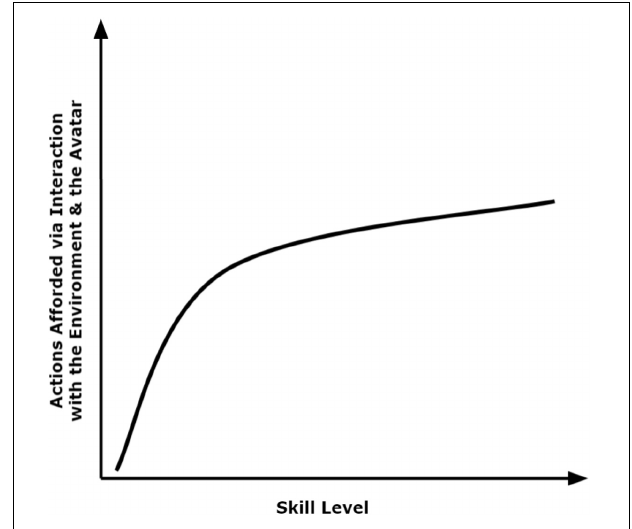
FIGURE 2 | The proposed logarithmic shape characterizing the relationship between user skill and afforded